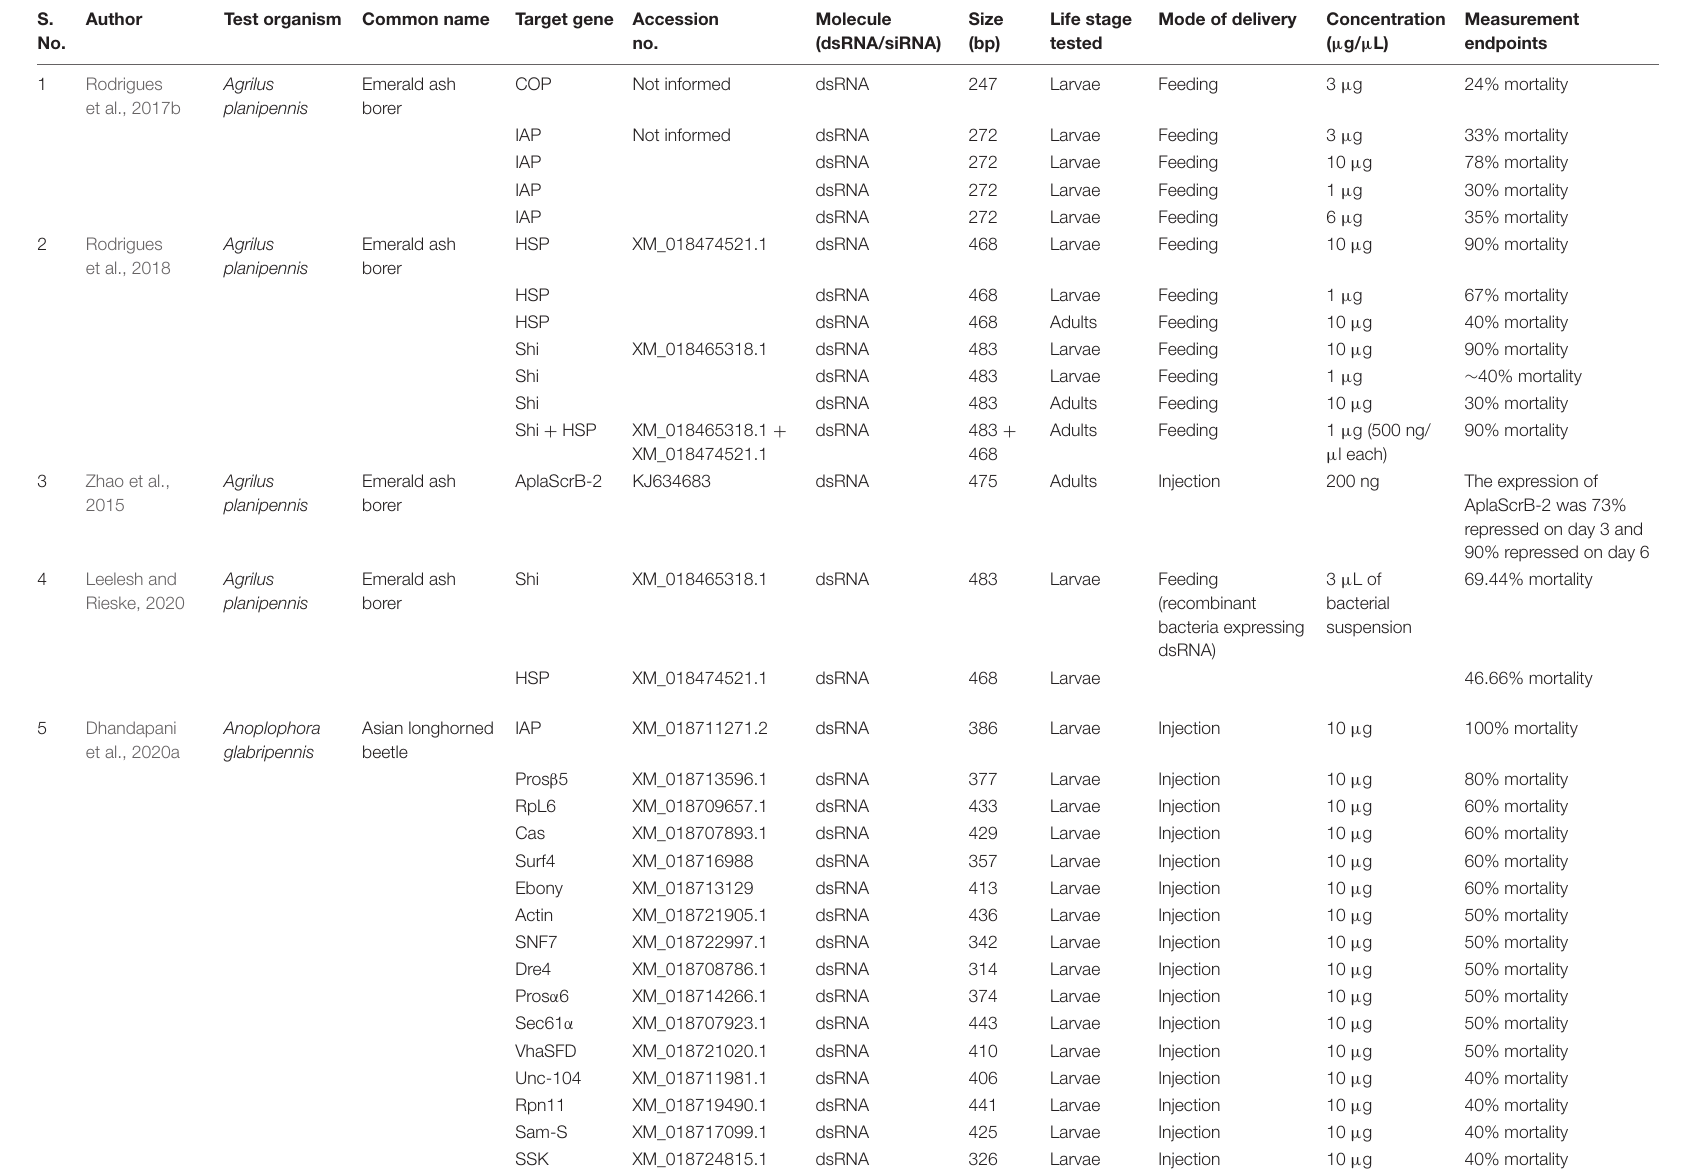
TABLE 1 | List of RNAi experiments for wood-boring coleopteran